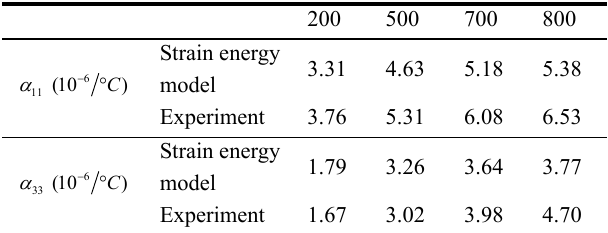
Table 2. Comparison of computed CTEs with experimental and numerical